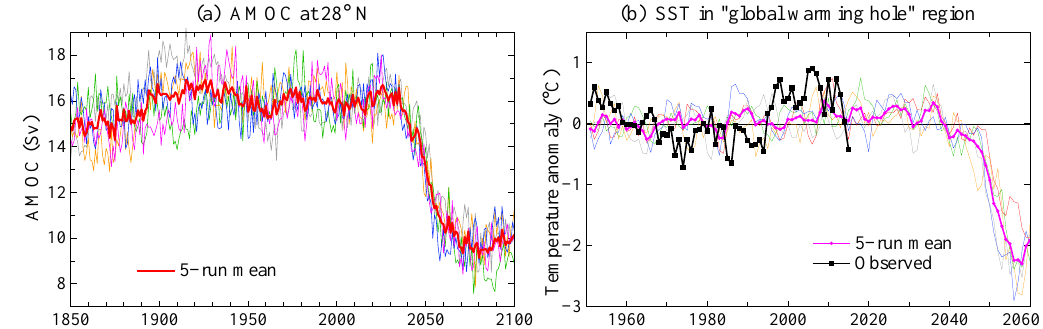
Figure 33. (a) AMOC (Sv) at 28 ◦ N in simulations with the forcings of Sect. 4.2 (i.e., including freshwater injection of 720Gtyear − 1 in 2011 around Antarctica, increasing with a 10-year doubling time, and half that amount around Greenland). (b) SST ( ◦ C) in the North Atlantic region (44–60 ◦ N, 10–50 ◦